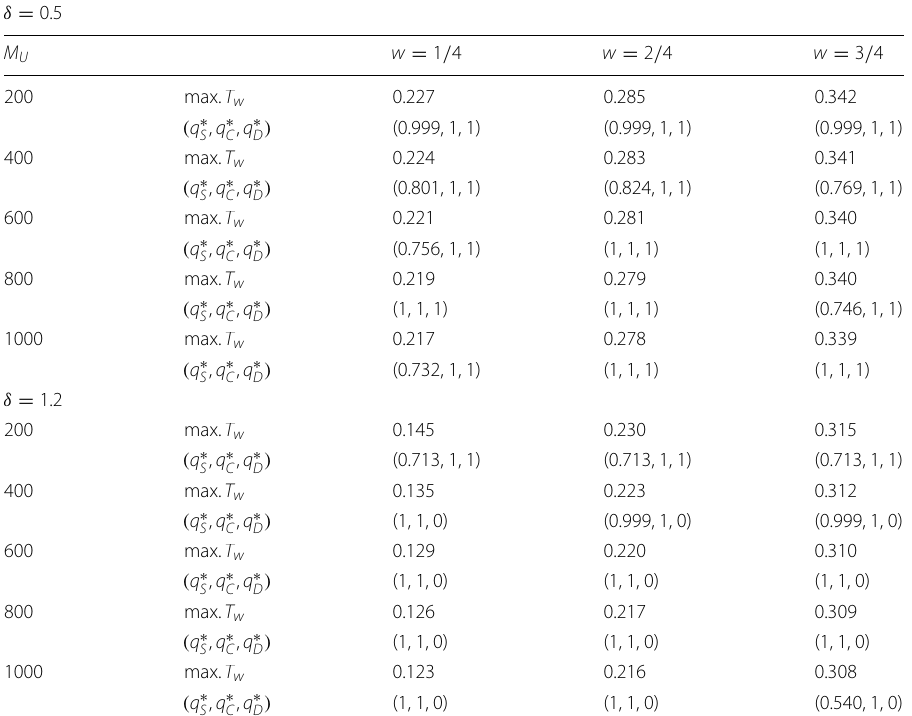
Table 6 The values of ( q ∗ of M U when α = 0.7 and the queue at S is stable δ =